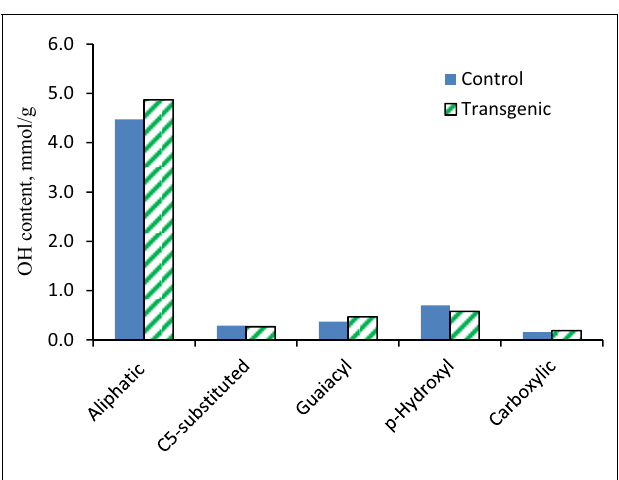
FIGURE 7 | Hydroxyl group contents (millimole per gram) in lignin samples isolated from the wild-type and COMT transgenic switchgrass as determined by 31 P NMR analysis